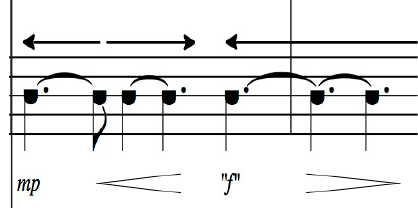
Figure 3. Bars 9 and 10 of et ego